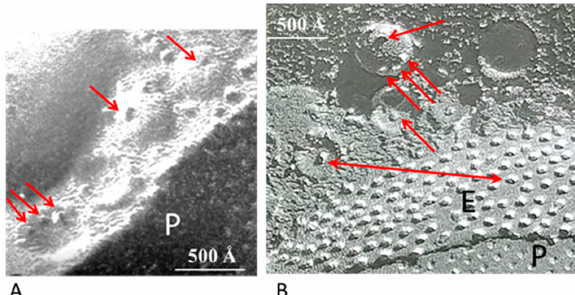
Figure 2. Freeze-fracture images of gap junctions between crayfish lateral giant axons ( A and B ). The neighboring vesicles contain particles and pits ( A and B , red arrows) similar in size to the junctional particle ( B ). Often, the particles of the vesicles display a central dimple similar in size to that of the junctional particles ( B , double-headed red arrow). P, Protoplasmic face; E, Exoplasmic face. A from [10].